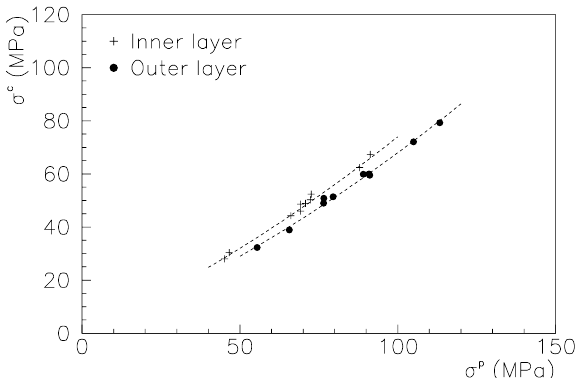
FIG. 10. Stress s (MPa) at ambient temperature versus total height of a stack of 22 conductors for the inner layer, loading and unloading curves from different peak stresses (treated ex- perimental